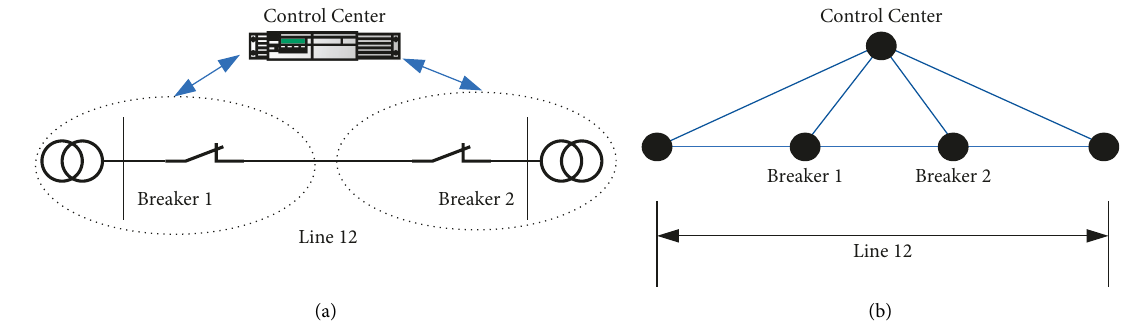
Figure 2: An example of node-to-node CPPS. (a) A micro CPPS. (b) The graph of the